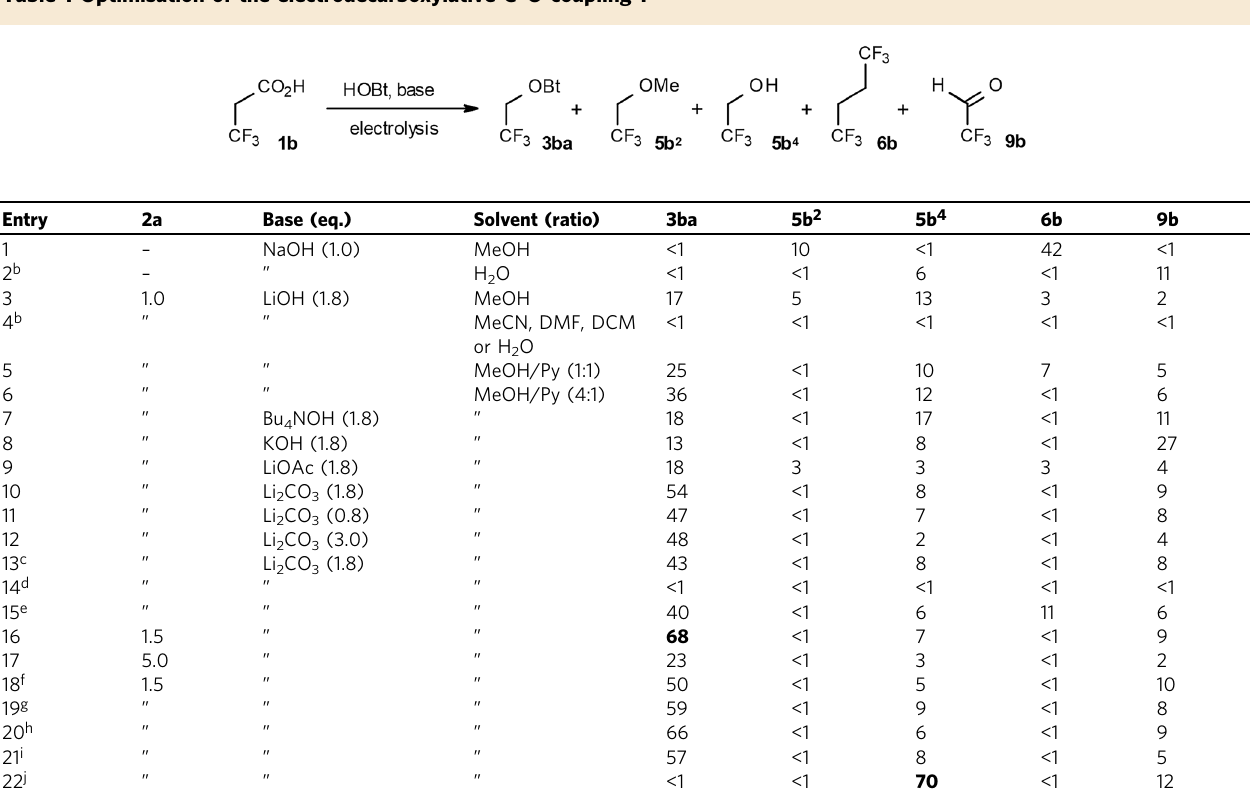
Table 1 Optimisation of the electrodecarboxylative C – O coupling a .